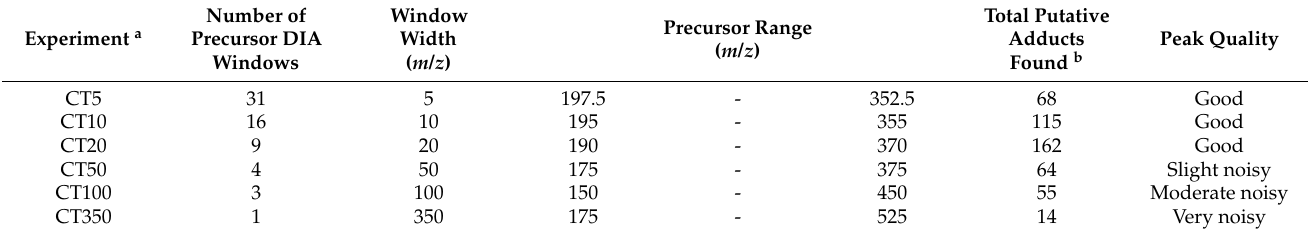
Table 1. Evaluation of nLossFinder from running at different DIA windows settings using a nucleoside mixture obtained from the digestion of ctDNA. a Experiments were named CT5, CT10, and so on based on the respective window width. b Only precursors above 10 4 peak area units were considered. Possible isotopes and ESI adducts were not removed. Experiment